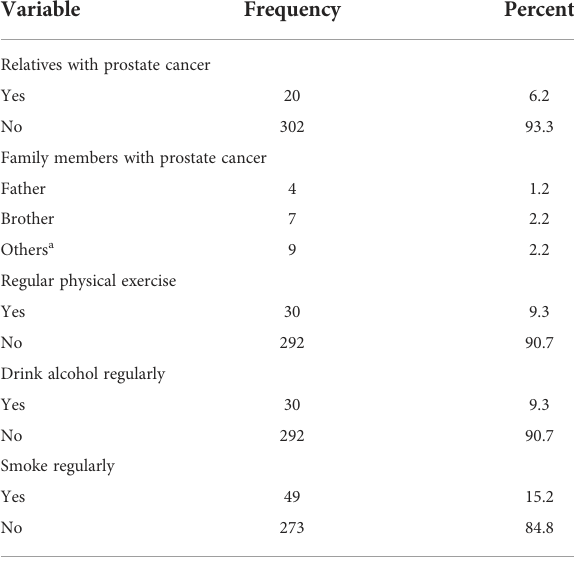
TABLE 2 History and risk factors of prostate cancer in men 40 years of age and older in Mizan Aman town, Bench Sheko zone in SNNPR, South West Ethiopia,